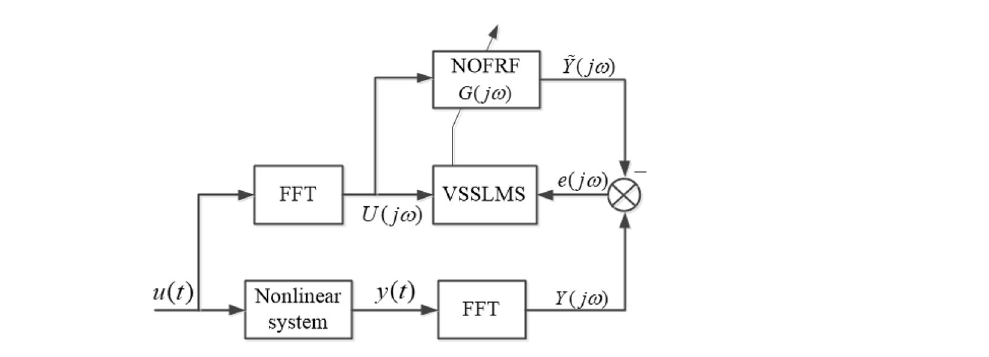
Figure 2. The schematics of NOFRF identification by